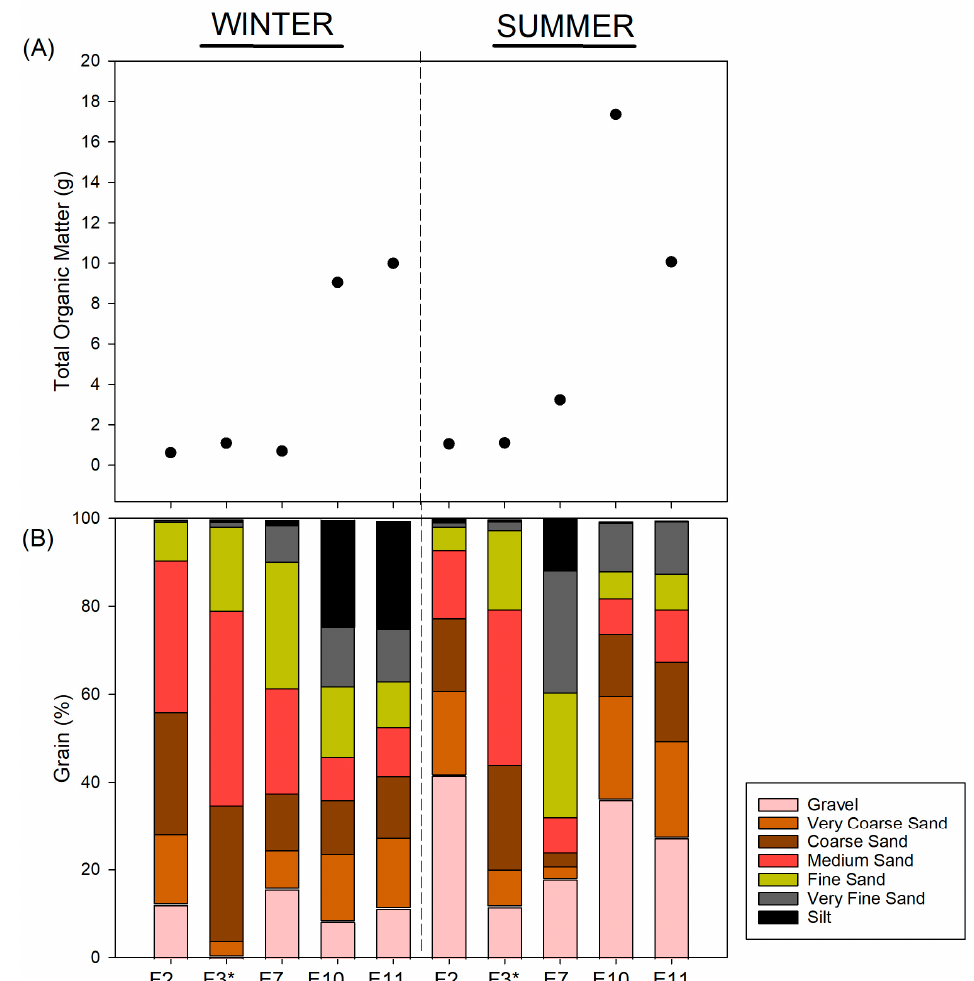
Figure 4. ( A ) Total organic matter percentage and ( B ) sediment granulometry distribution. * Discharge Station.